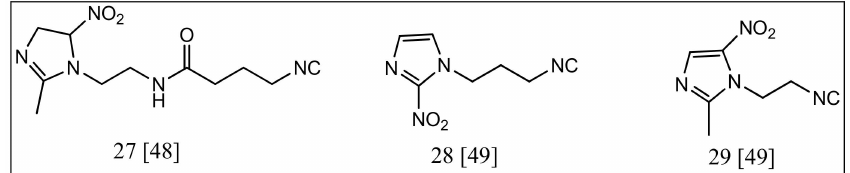
Figure 7. Molecular structure of isonitrile ligands used for labelling with technetium through the formation of 4 + 1 Tc(III) complexes